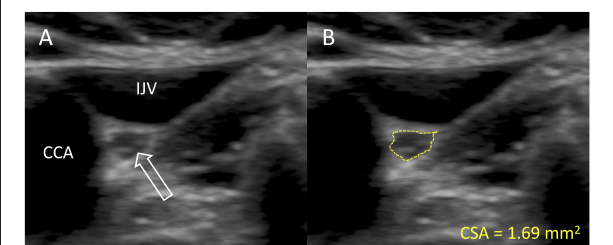
FIGURE 1 | Representative ultrasound image of the vagus nerve. (A) The vagus nerve (white arrow) of a patient with PD. (B) Delineation of the same vagus nerve following the hyperechoic epineurium. IJV, internal jugular vein; CCA, common carotid artery; CSA, cross-sectional area.